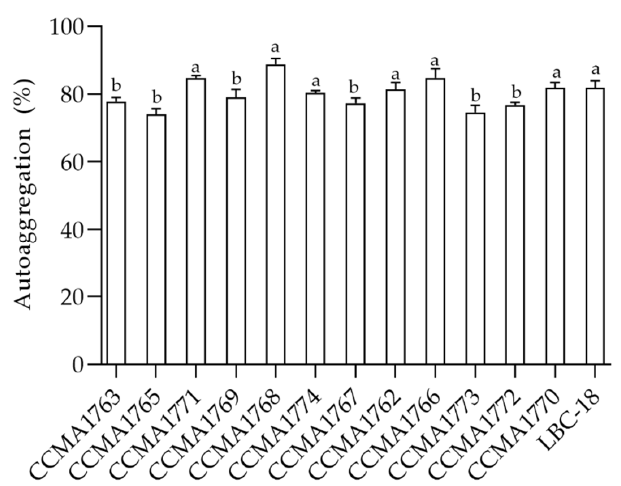
Figure 2. Percentage of auto-aggregation of LAB isolates Bar indicates SD. Bars followed by different letters differ significantly ( p < 0.05) by the Scott–Knott test.